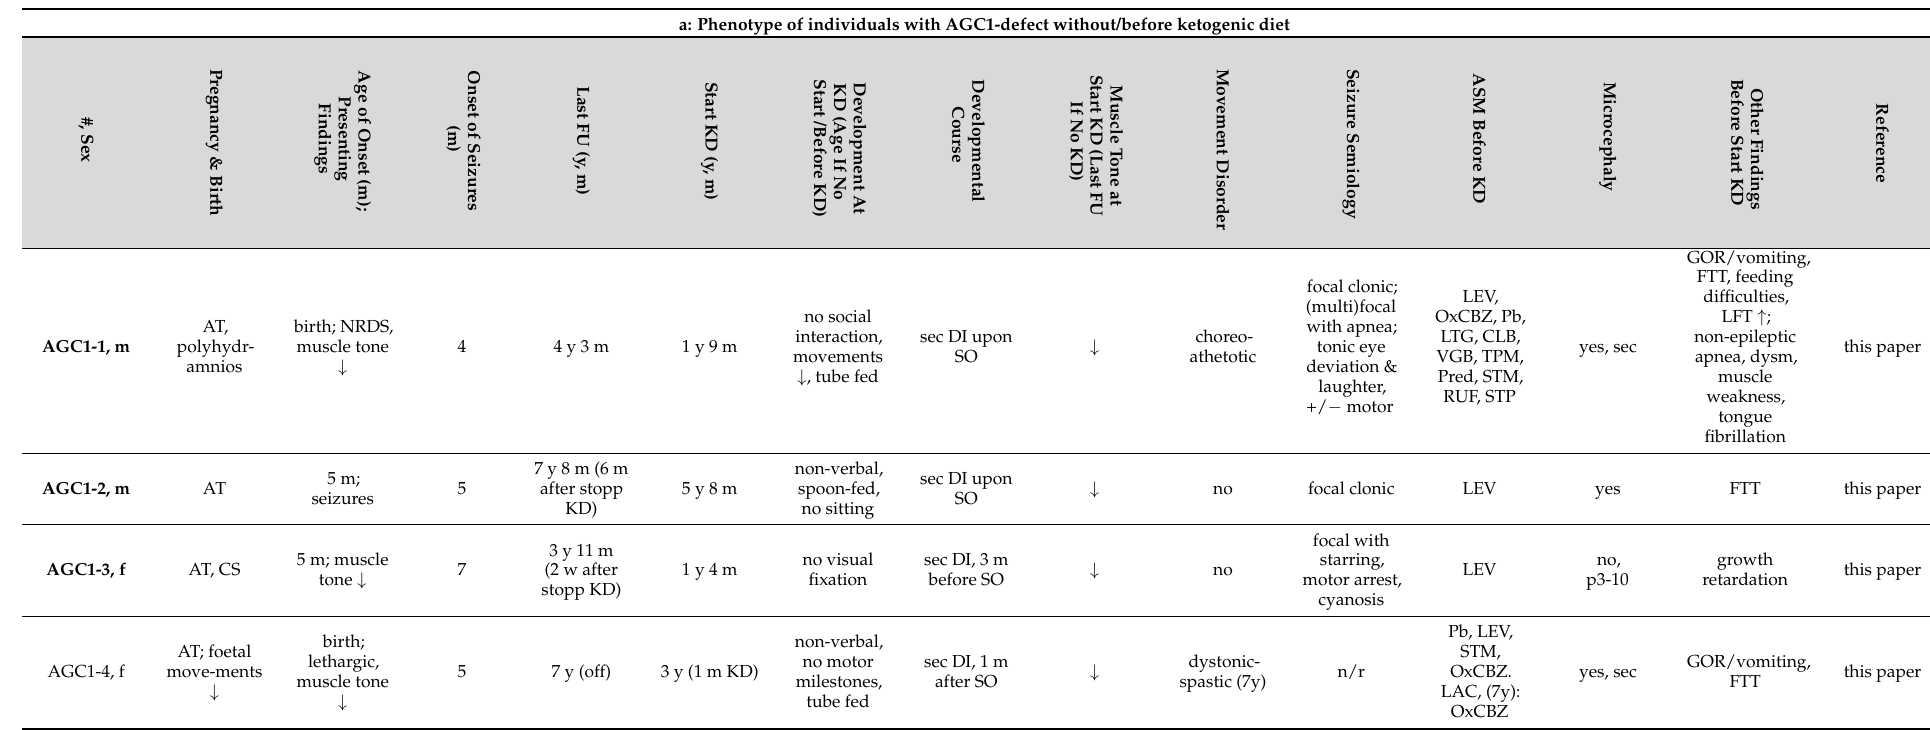
Table 1. a–d : Phenotype of neurological MAS without/before ketogenic diet . Legend 1. a–d: in bold are the patients that received > 1 month ketogenic diet or serine & pyridoxine, respectively. n/r = not reported, wg = weeks of gestation, ↓ = reduced, ↑ = increased, d = day(s), w = week(s), m = month(s), p = percentile, prim = primary, sec = secondary, regr = regression, prog = progressive, neg = negative, gen = generalized, FU = follow up, AT= at term, PT = preterm, CS = cesarean section, preg = pregnancy, neo = neonatal, NICU = neonatal intensive care unit, NRDS = neonatal respiratory distress syndrome, DI: developmental impairment, SO = seizure onset, SE = status epilepticus, GOR = gastro-oesophageal reflux, FTT = failure to thrive, LFT = liver function test(s), AB = antibody, † = deceased, met = metabolic, resp = respiratory, dysm = dysmorphic, ASM = anti-seizure-medication, BRV = brivaracetam, esliCBZ = eslicarbazepine, LAC = lacosamide, LEV = levetiracetam, LTG = lamotrigine, CBZ = carbamazepine, OxCBZ = oxcarbazepine, Pb = phenobarbitone, CLB = clobazam, CLN = Clonazepam, VGB = vigabatrin, VPA = valproate, Pred = prednisolone, RUF = rufinamide, STM = sulthiame, STP = stiripentol, TPM = topiramate, ZNS =